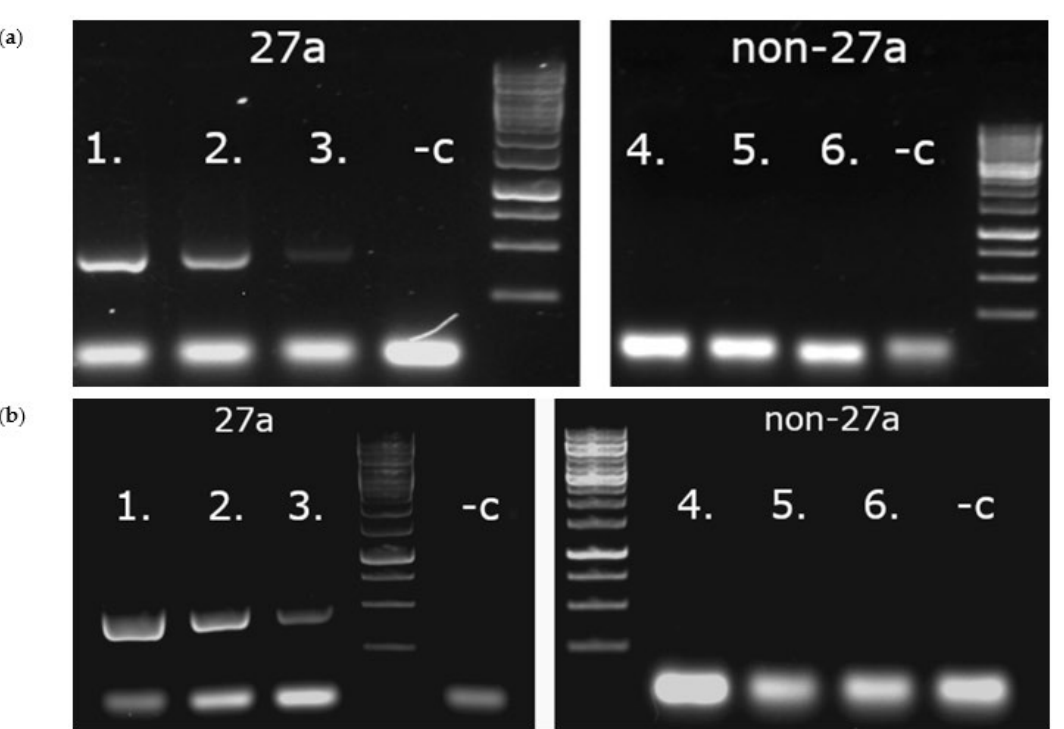
Figure 5. Efficiency of DreamTaq ( a ) and DreamTaq Hot Start ( b ) enzymes on different 27a and non-27a templates. Numbers 1–3 are three different 27a samples; 4–6 are three different non-27a samples; -c is negative control; markers are GeneRuler 1 kb DNA ladders.